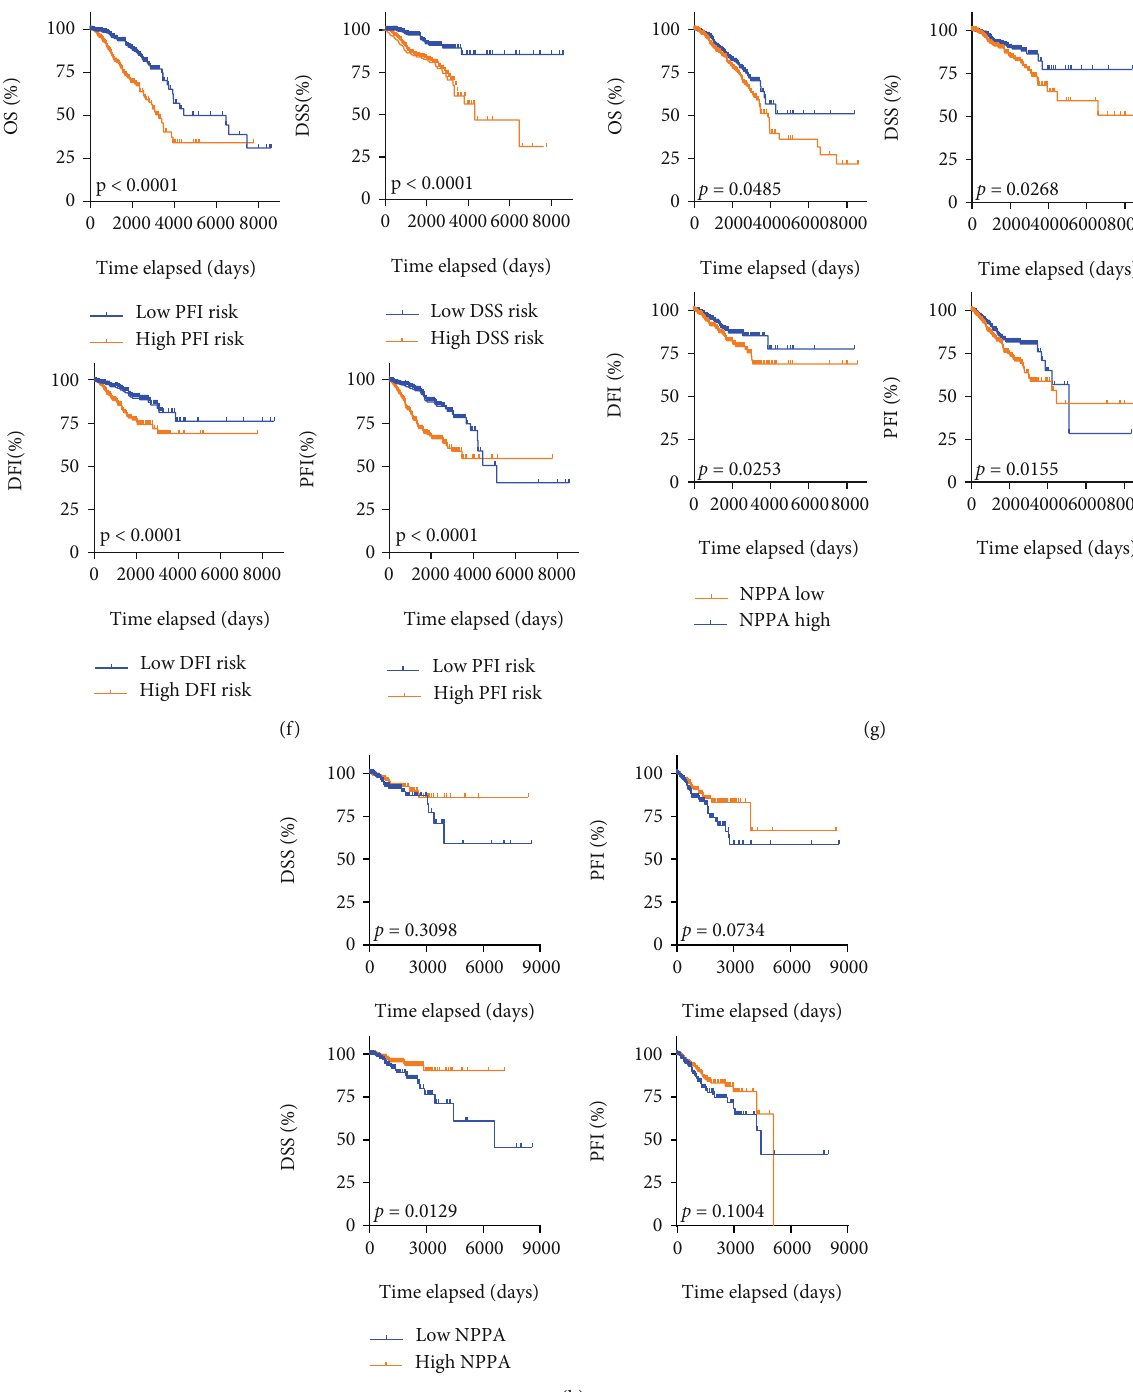
Figure 2: Identi fi cation of NPPA as an independent prognostic marker for breast cancer patients. (a) Heatmap showing the marker genes in SC3 clustering results. (b) Volcano plot showing the signi fi cance of genes in Cluster 1 vs. Cluster 2 and in SC3 clustering result. Mutually signi fi cant genes were de fi ned as marker genes and were labeled in red. (c) Heatmap showing the expression of ECM marker genes in